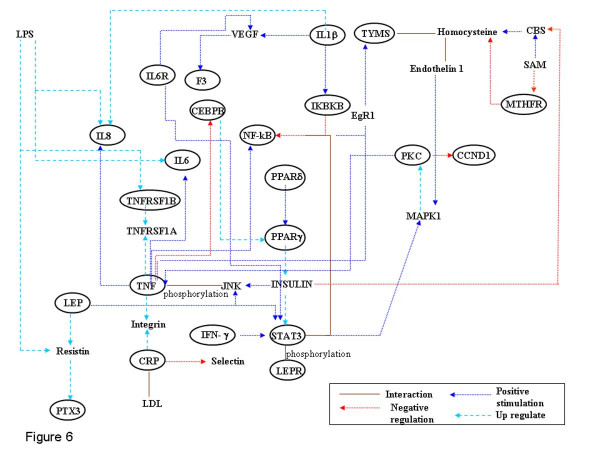
Interactions between proinflammatory cytokines. The interaction between different proinflammatory cytokines is shown which may be modulated by homocysteine levels resulting in pathological consequences.